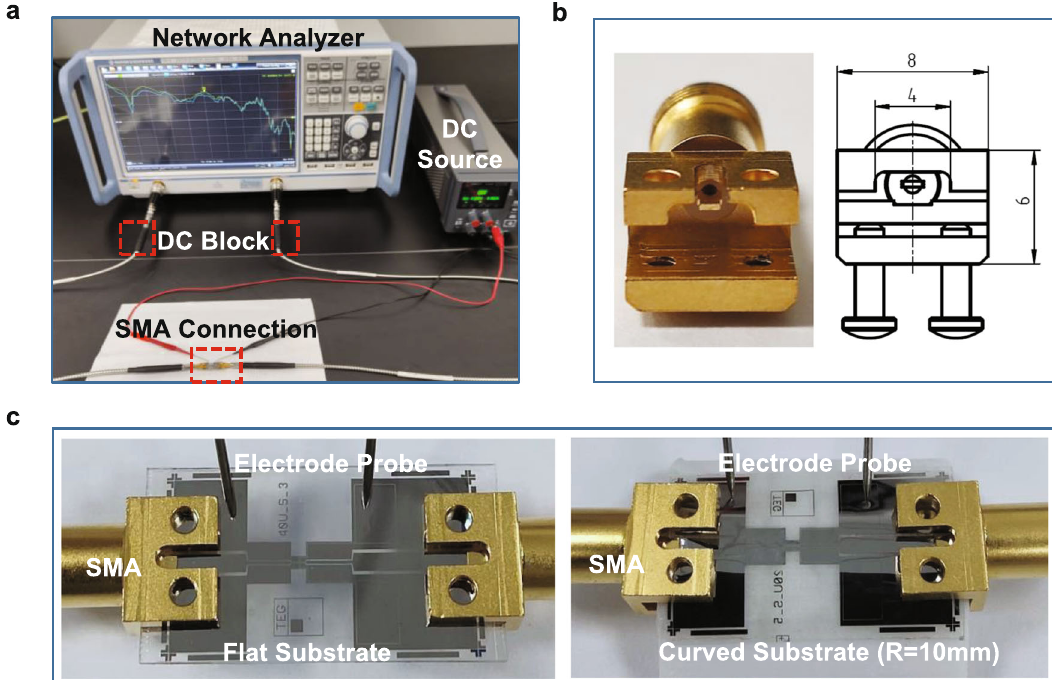
Fig. 5 RF performance measurement platform and SMA connector. a Measurement platform with network analyzer, DC source, DC block, SMA connection and probes. b The SMA connector used to measure the RF performance of the switch (Impedance: 50 Ω ; Frequency: DC − 40 GHz). Connection diagram between ( c ) fl at substrate and SMA, curved substrate (Radius: 10 mm) and